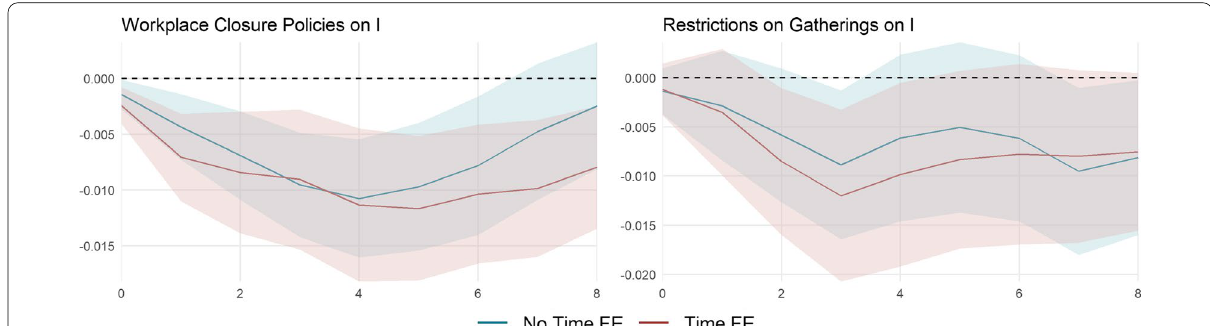
Fig. 9 Cumulative impulse responses of infection growth I . The impulse responses are estimated using the local projection specification in (5) with ln R e with (red) and without (blue) time fixed effects. The data span September 28, 2020, until April 18, 2021. The P (cid:31) KSI + , B (cid:31) lnNTRX , and I = = = shaded areas represent the 95% confidence intervals based on standard errors corrected for serial correlation. The horizontal axes depict the time horizon in weeks. The vertical axes show the level response of the respective KSI +